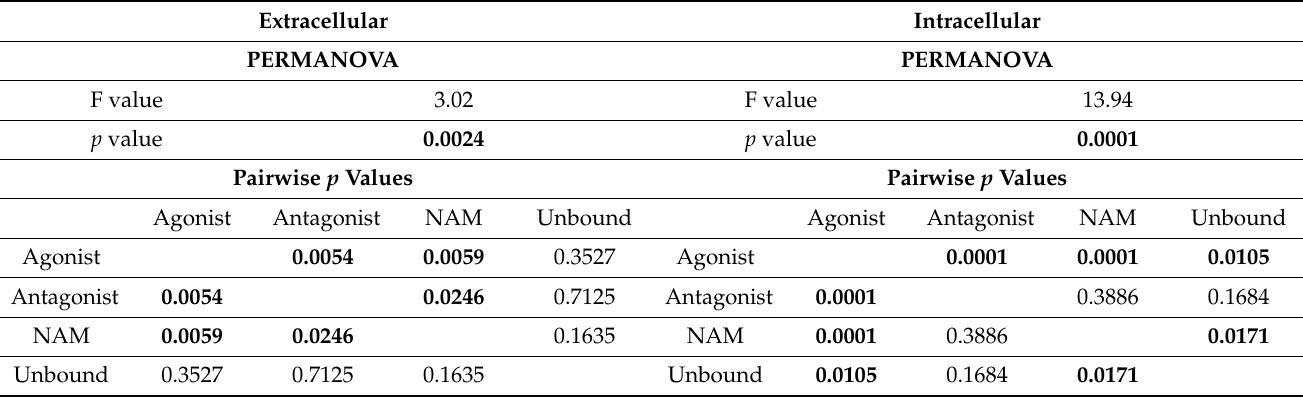
Table 5. A summary of PERMANOVA (distance) test data for the extra- and intracellular faces of the family B receptors, to support Figure 4. For statistical analysis, the partial agonist structure (5YQZ) was included in the agonist group; 9999 permutations performed on PC1-5, significant p values (<0.05) are shown in